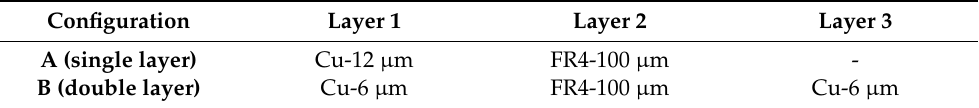
Figure 11. Sectional view of the PCB card shielded with a BLS type enclosure 3D model.